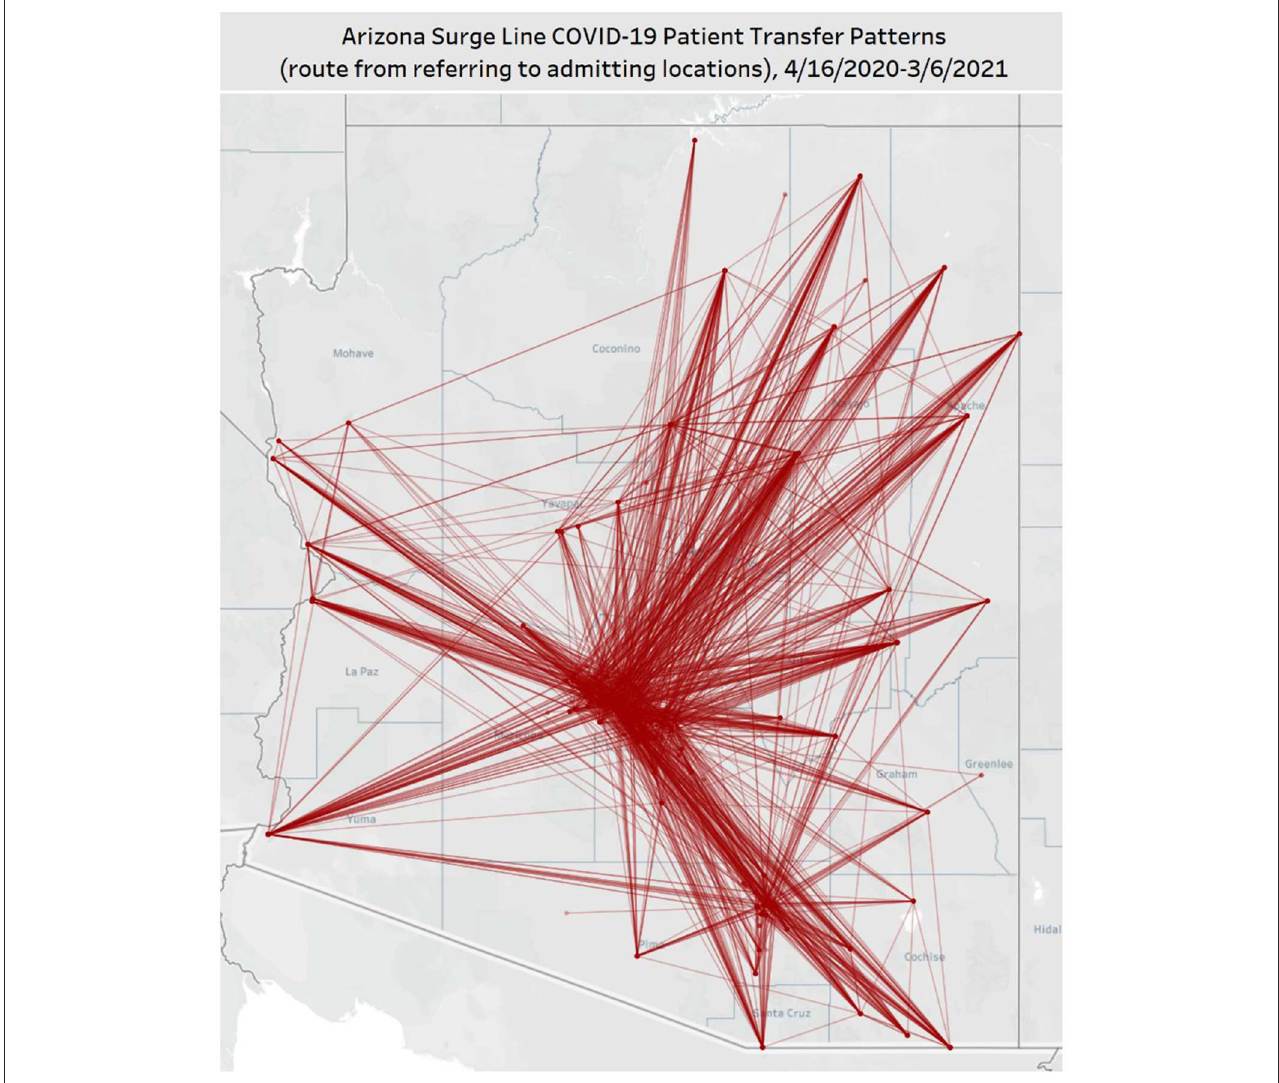
FIGURE4 Map of hospital-to-hospital transfers completed through the ASL for Surge 1 (4/16/20–9/19/20) and Surge 2 (9/20/20–3/6/21). In this map of Arizona, each line represents a route patients took between sending and receiving facilities, as facilitated by the Arizona Surge Line. The time frame represents the first two COVID-19 surges in Arizona. 61% of transfers went from rural to urban